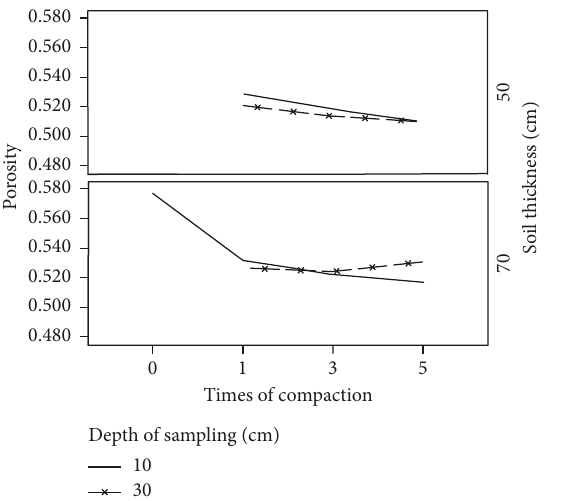
Figure 7: Change of the porosity of different depths of sampling and soil thickness to times of compaction.